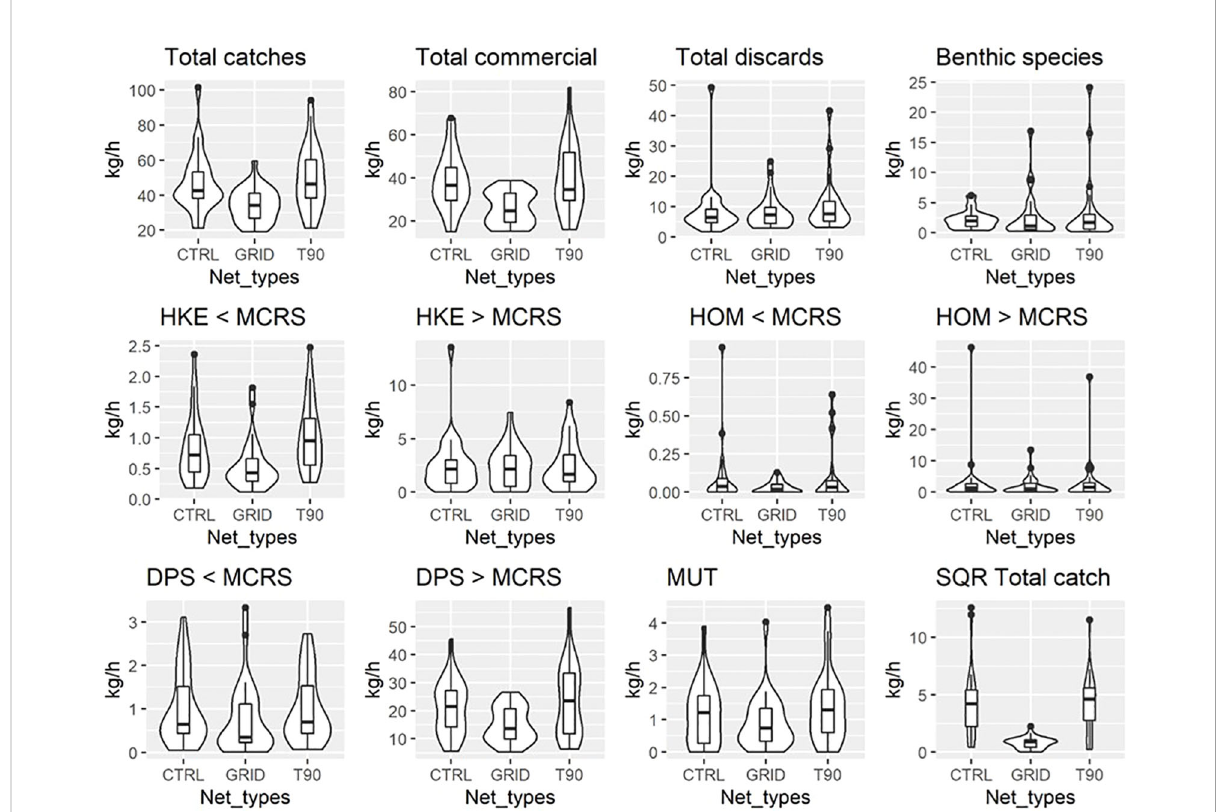
FIGURE 6 Violin plots in kg h-1 for the three types of net. The lower and higher lines of the boxes are the fi rst and third quantile, respectively; the bold line is the median and the vertical lines delimit the minimum and maximum values excluding outliers. The kernel probability density of the data at different values is also